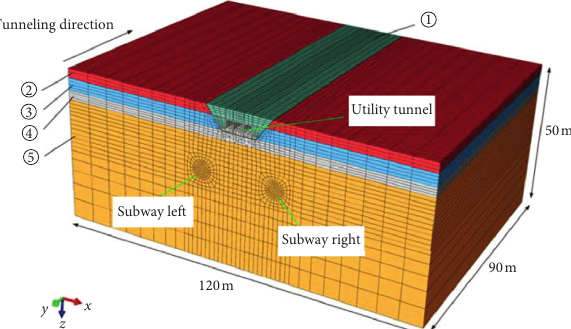
Figure 8: Numerical model of engineering.